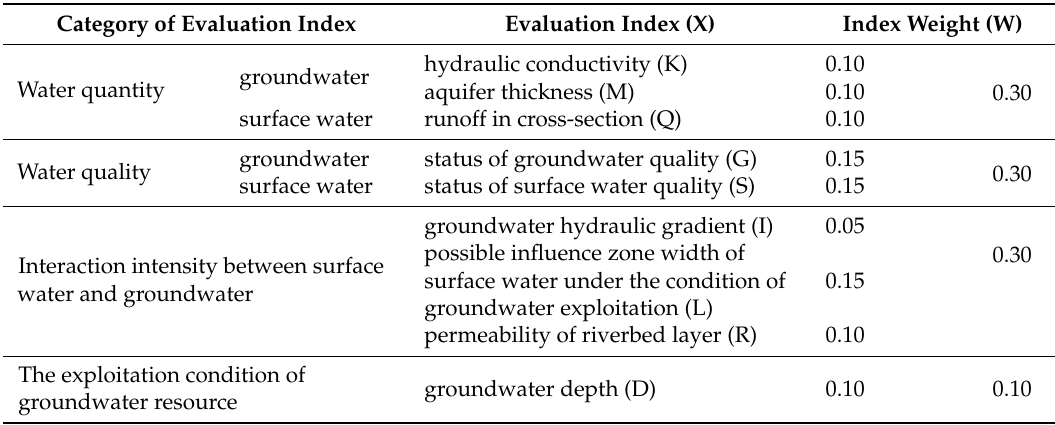
Table 2. RBF suitability evaluation index